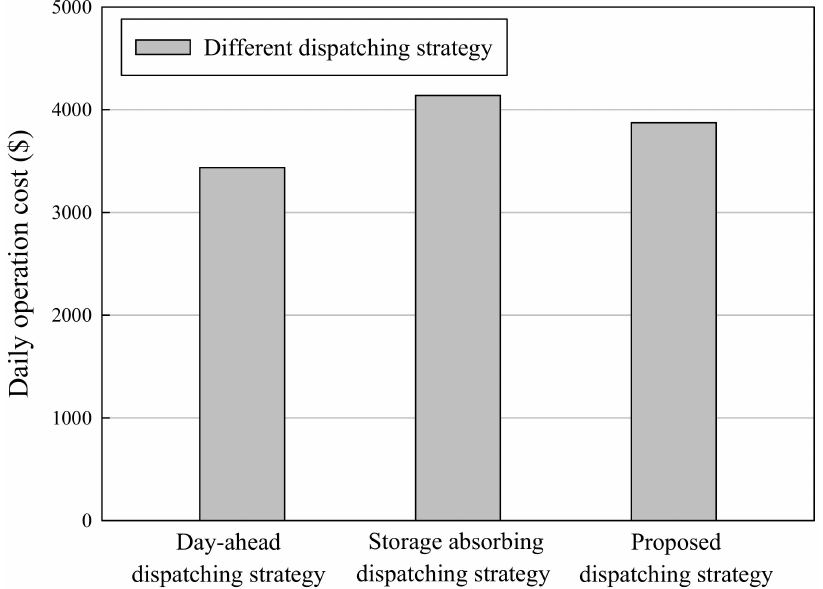
Figure 16. Comparison of daily operation costs under three dispatching